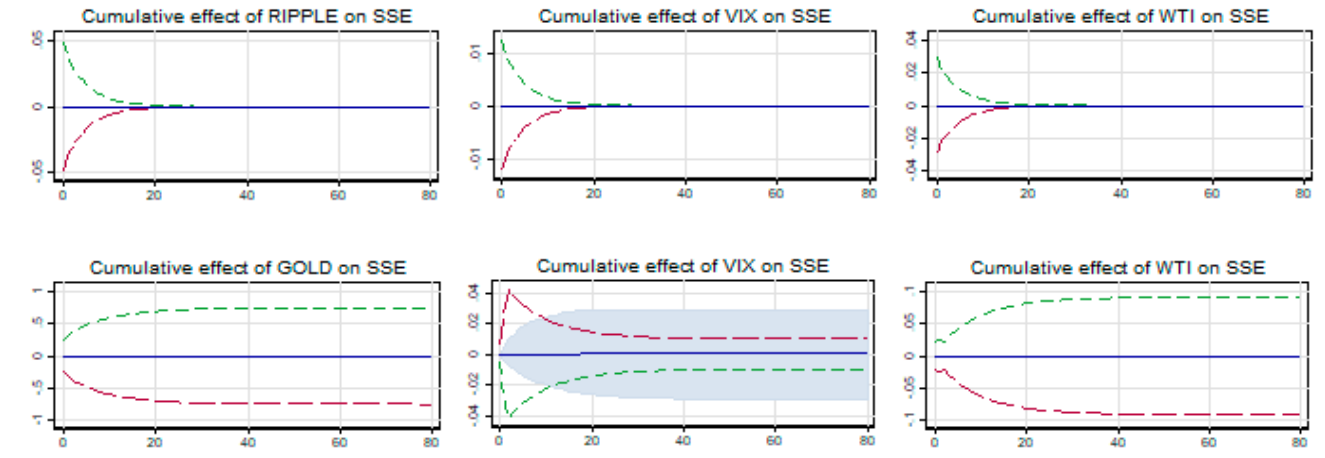
Figure 9. Cumulative effects of cryptos and gold on SSE.